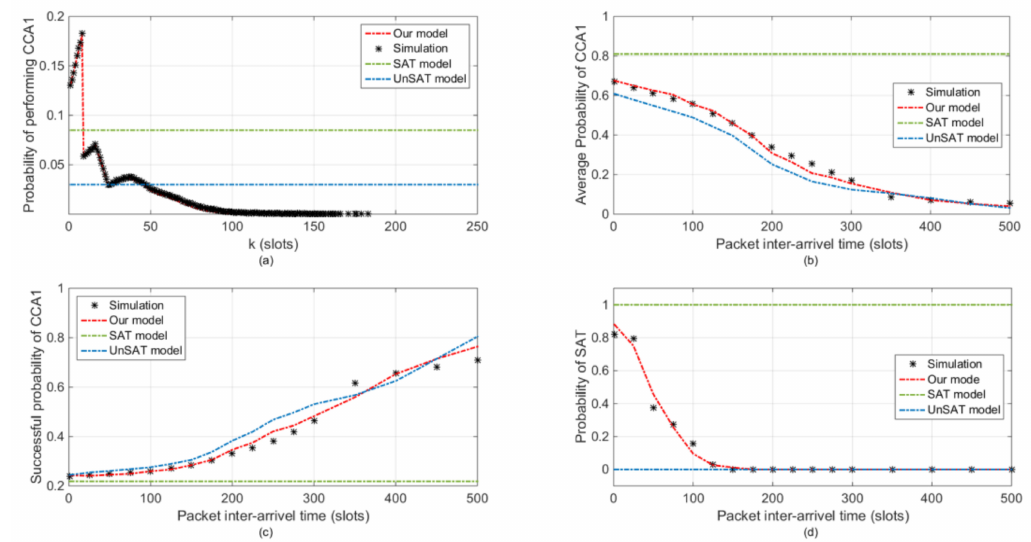
Figure 5. Local statistics comparison. ( a ) Probability of performing CCA1 ω 1 . ( b ) CCA1